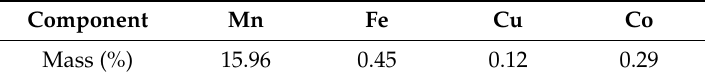
Table 1. Chemical analysis of the manganese ore.